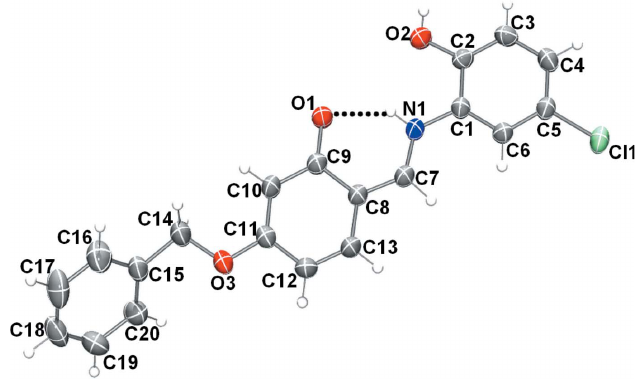
Figure 2 The molecular structure of compound (II), with the atom labeling. Displacement ellipsoids are drawn at the 50% probability level. The intramolecular N—H (cid:3)(cid:3)(cid:3) O hydrogen bond is shown as a dashed line.